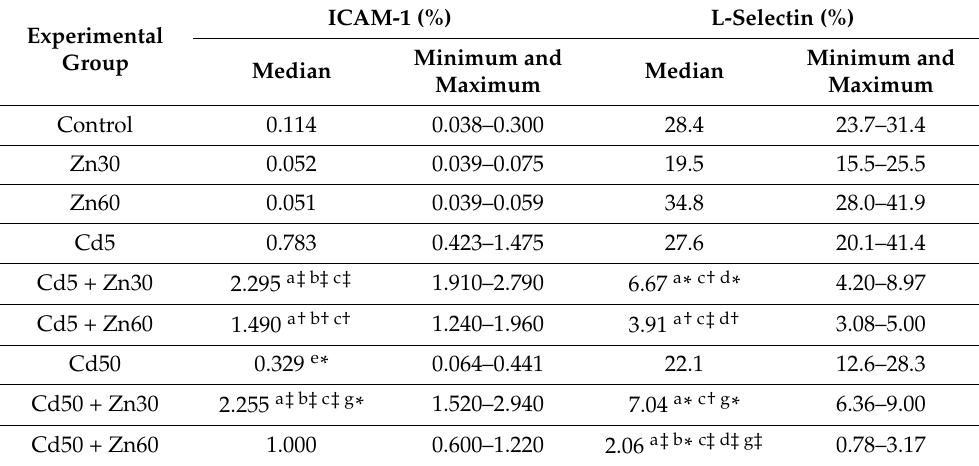
Table 7. The expression of ICAM-1 and L-selectin on leukocytes in the blood in particular experimen- tal groups 2